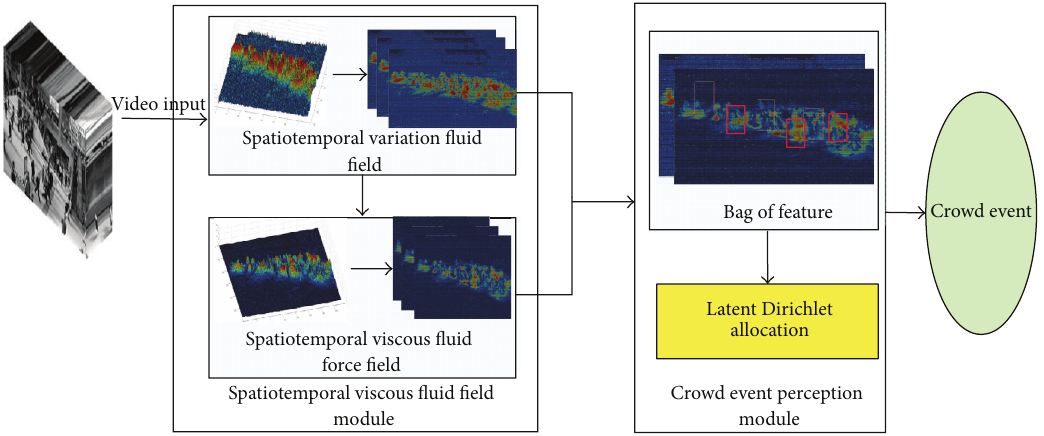
Figure 4: System structure of crowd behavior